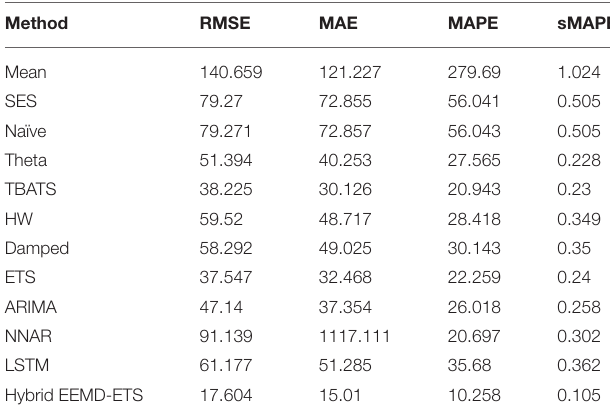
TABLE 10 | Performance comparison of different models for 7 days prediction of Germany’s daily deaths.